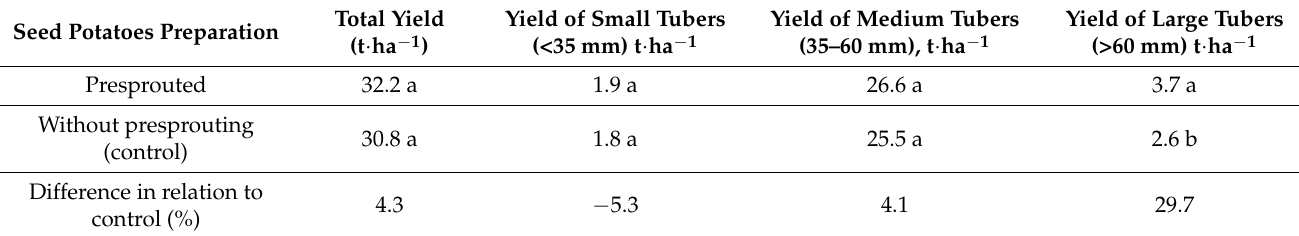
Table 3. The influence of seed potatoes presprouting on tuber yield and tuber size distribution (Jadwisin,